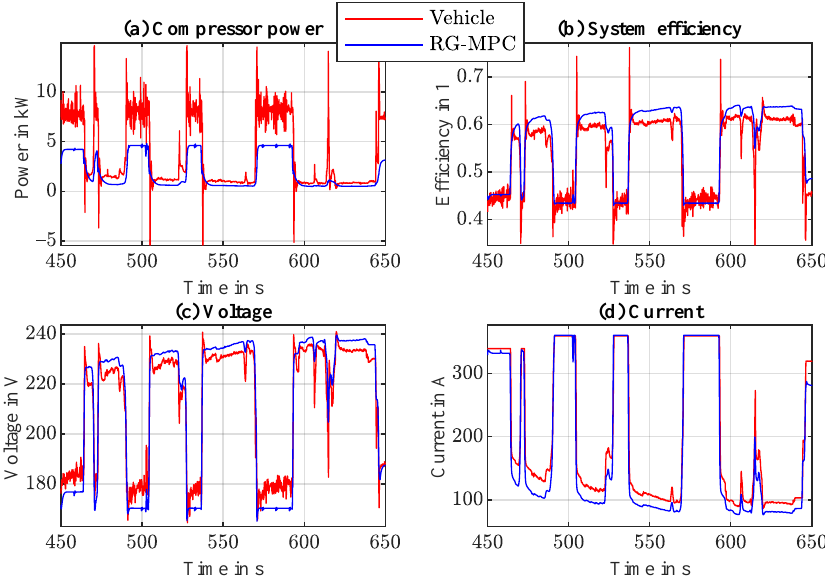
Figure 8. ( a ) Compressor power, ( b ) system efficiency, ( c ) stack voltage, ( d )